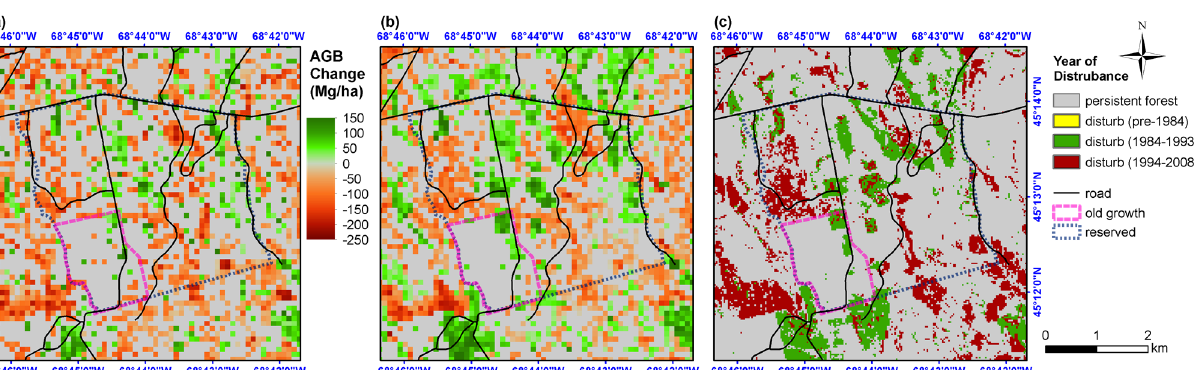
Figure 10. Field-measured biomass as an exponential function of SAR backscatter. ( a ) PALSAR HV, ( b ) UAVSAR HV; the Y-axis shows the field-measured biomass density at the 1.0 ha plot-level, and X-axis shows SAR backscatter at HV polarization in decibel (dB); red solid line is the prediction curve; blue dashed lines indicate the 95% confidence intervals for the predictions.